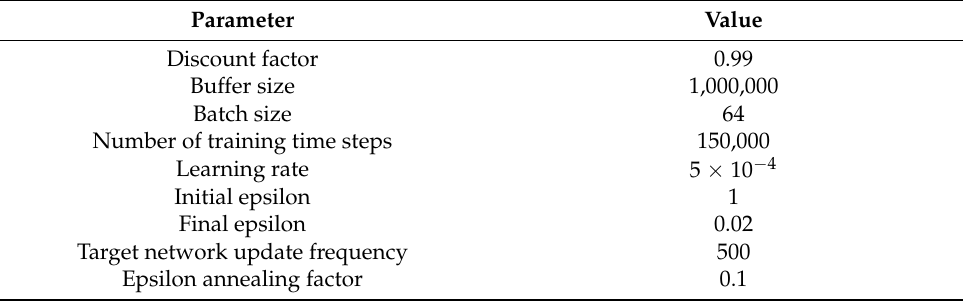
Table 2. Experimental parameters for DQN and DDQN